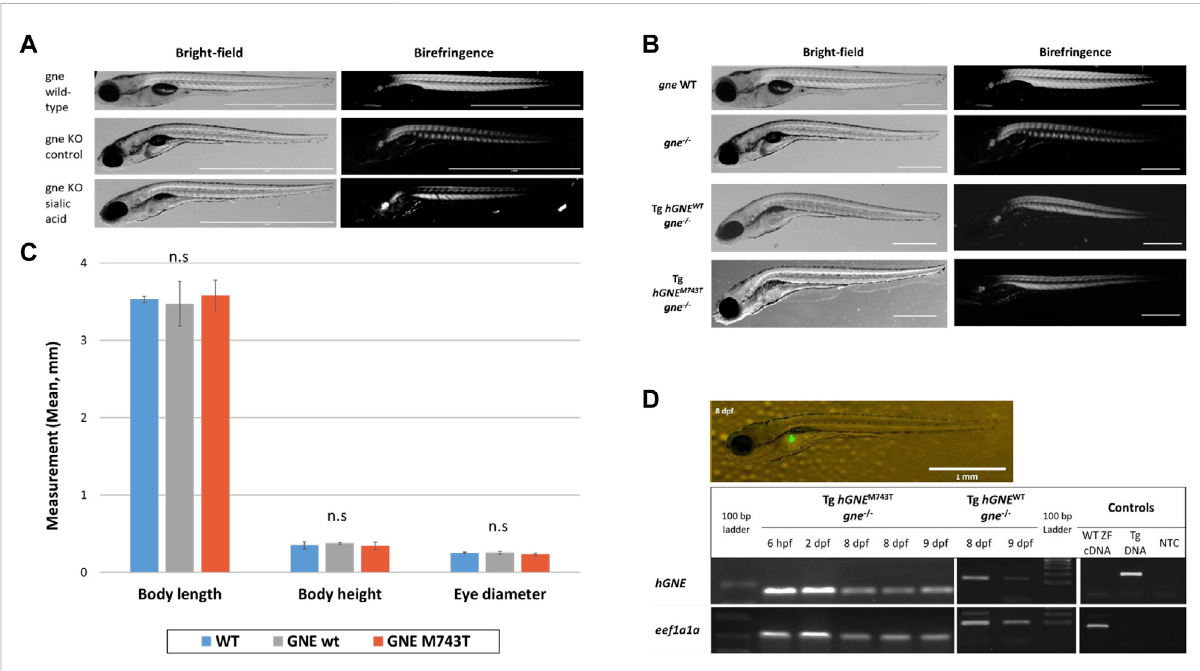
FIGURE 8 Exogenous sialicacidor hGNE transgeneexpressiondoesnotrescue the gne KOlarvae. (A) Bright fi eldandbirefringencerepresentativeimages of 8 dpf larvae that participated in the sialic acid supplementation experiment: gne WT (top), gne KO (middle) and gne KO larvae with 800 μ M sialic acid supplementation (bottom). The addition of sialic acid did not ameliorate the muscle phenotype, nor rescued gne KO larvae from mortality at 8 – 10dpf. (B) Bright fi eldand birefringence images ofGNEmyopathygeneticmodellarvae displayaphenotype similarto gne KOlarvae at8dpf. (C) No signi fi cant differences were detected in morphologic measurements (body length, body height, eye diameter) between wild-type and hGNE M743T or hGNE WT transgenic KO models at 8 dpf. (Mann-Whitney Wilcoxon test, p > 0.05). Means of 10 larvae/variable/genotype and correspondingstandarddeviationsarepresented. (D) Transgeneexpressionvalidation.Top:Fluorescentimageofarepresentative8dpfTg( ins :EGFP; hGNE M743T ;gne − / − ) larva showing EGFP expression in the pancreas. Scale bar = 1 mm. Bottom: Agarose gel electrophoresis of RT-PCR ampli fi cation products of the hGNE cDNA and eef1a1a . cDNA samples from both hGNE M743T and hGNE WT transgenic KO models show the expected ampli fi